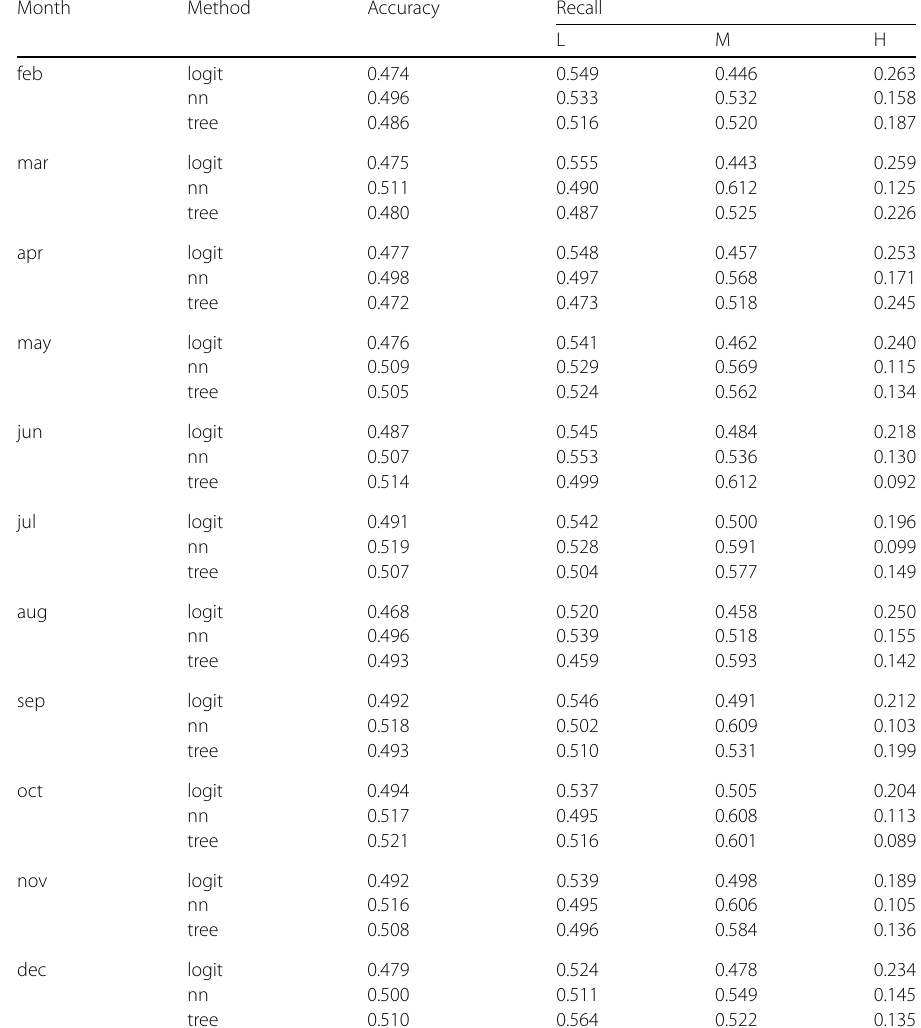
Table 16 Accuracy and recall for other for all months